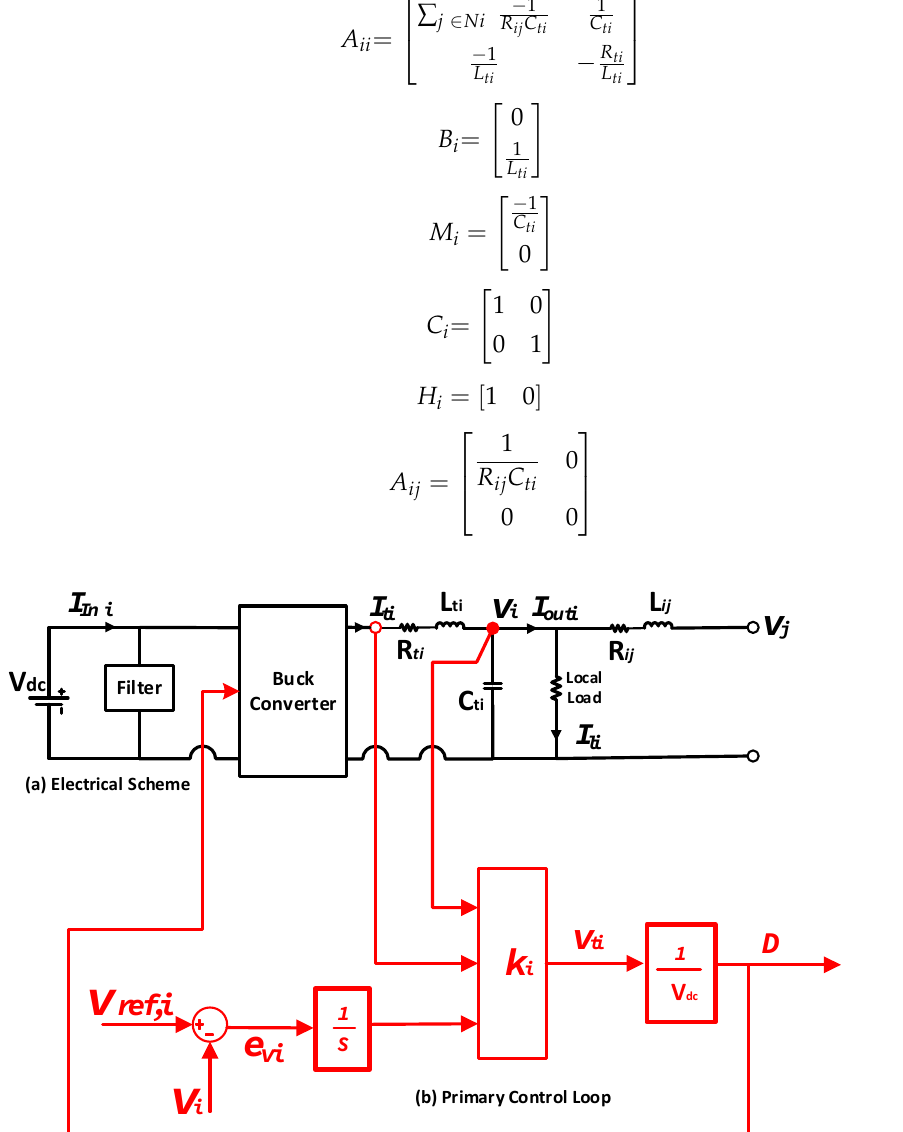
Figure 2. Distributed generator unit i with local primary voltage controller: ( a ) electrical scheme and ( b ) state feedback primary control loop.